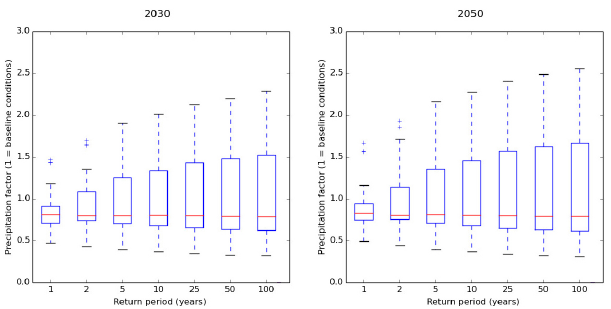
Figure 7. Box-and-whisker plots showing the distributions of pre- cipitation factors (where a factor of “1” equals baseline conditions) for extreme 1-day precipitation for several return periods, ranging from 1 to 100 years. The results are shown for 2030 and 2050. The results are based on five GCMs and four RCPs. The box plots show the median values for the 20 GCM–RCP combinations (red lines), the 25th and 75th percentiles (top and bottom of boxes), and the range (whiskers). Outliers as shown as “ +